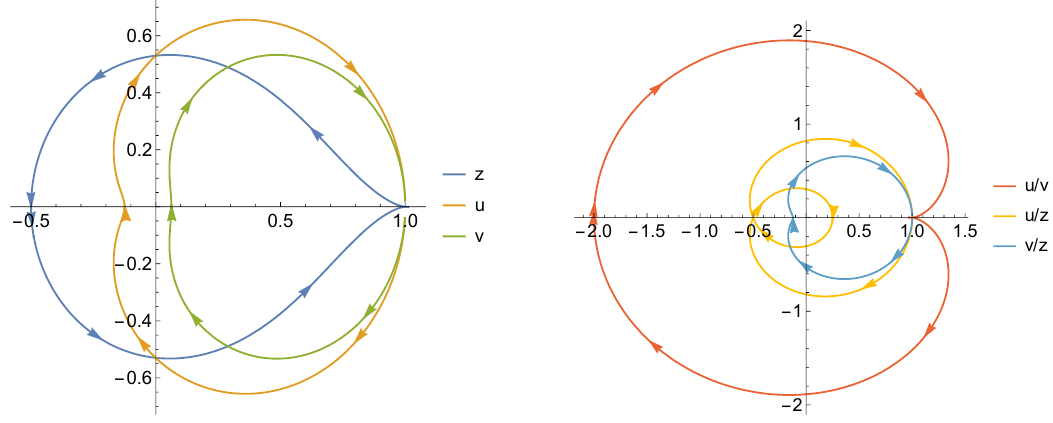
Figure 4 . The trajectory followed by the various cross-ratios under analytic continuation to Lorentzian times. To make this (cid:12)gure we chose (cid:12) = 2, (cid:27) W = 0 : 5, (cid:27) Y = 0 : 25, and (cid:27) X = 0, as well as t X = 2 t Y , with t W = 0. The anti-holomorphic cross-ratios do not cross any branch cuts. of branch cuts crossed are of those of the logarithm, which extendes from ( (cid:0)1 ; 0] and the branch cut of the dilogarithm, which extends from [1 ; 1 ). These